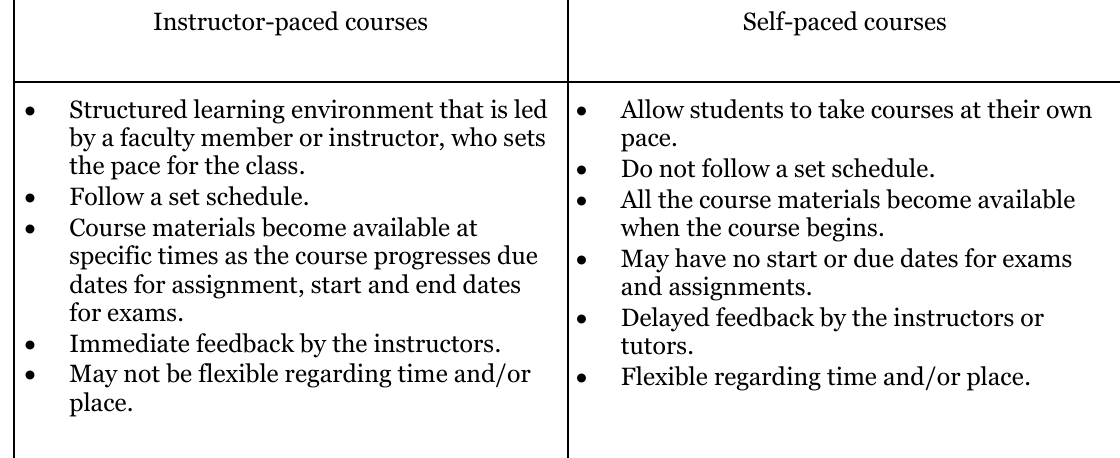
Instructor-Paced vs. Self-Paced Courses Instructor-paced courses Self-paced